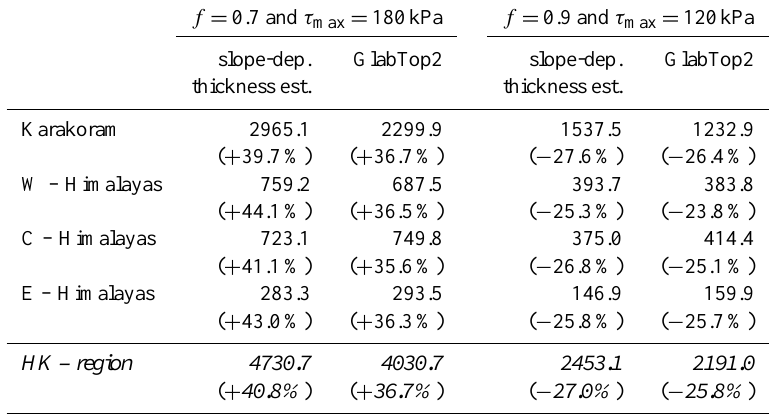
Table 6. Total ice volumes (km 3 ) calculated with the slope-dependent thickness estimation approach and GlabTop2, using modified param- eters f and τ max . Parameterizations of τ as shown in Fig. 4, relative change to ice volumes calculated with original parameterization given in brackets.